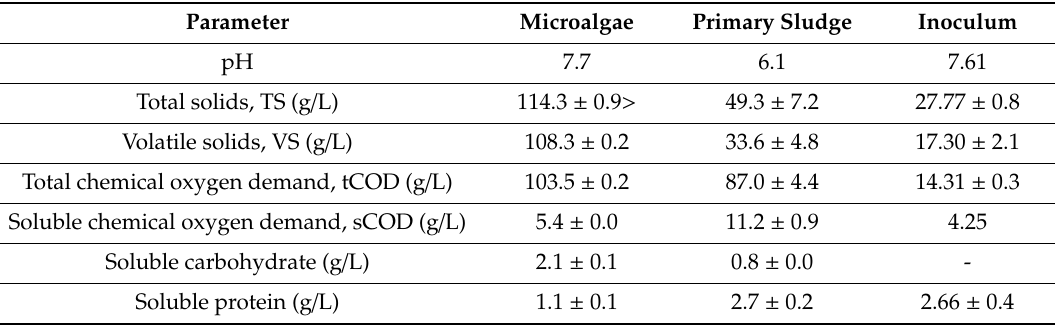
Table 1. Characteristics of the raw micro-algal biomass, raw primary sludge and